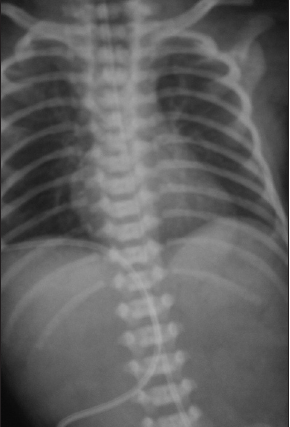
Fig ure 1: G-tube in the esogastric junction, no distal bowel gas.